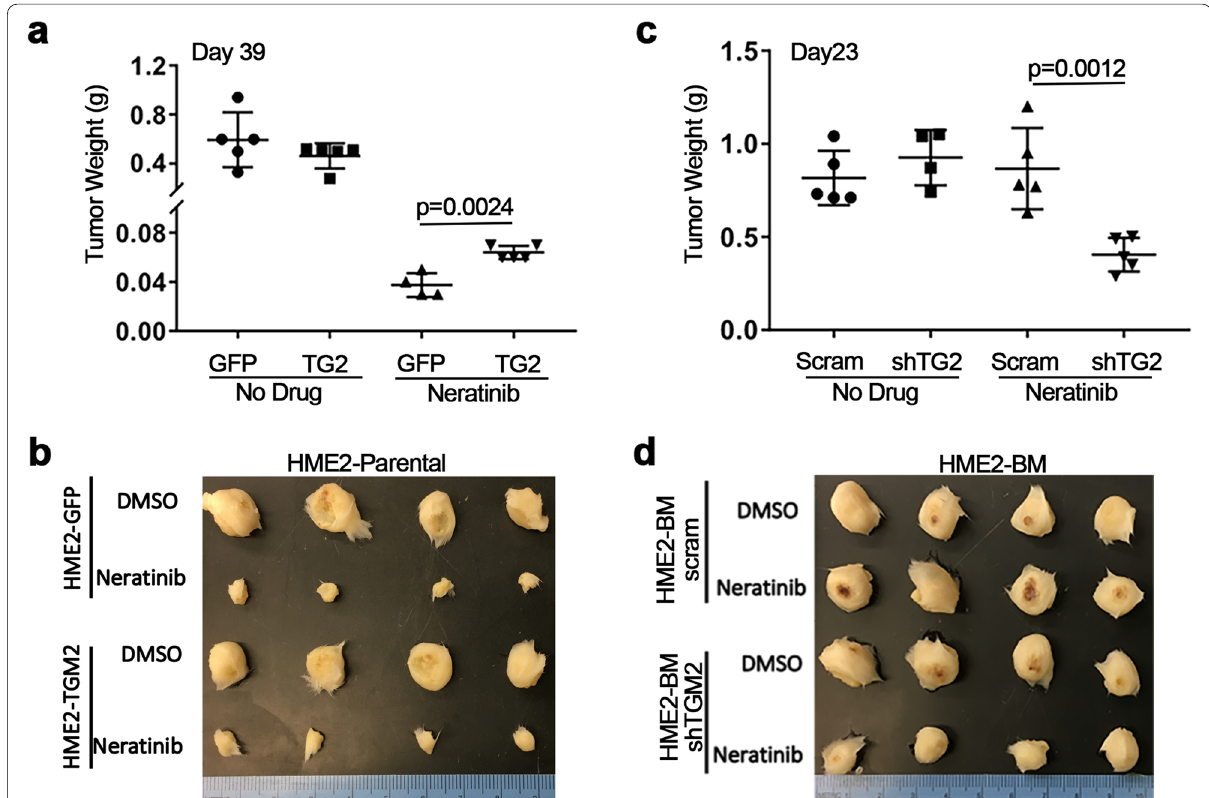
Fig. 2 Transglutaminase 2 facilitates neratinib resistance in vivo. a,c HME2 parental cells expressing GFP or TG2, and HME2-BM cells expressing a control (scram) or TG2-targeted shRNA (shTG2) were injected into the mammary fat pad. Tumor bearing mice were treated with neratinib as described in the material and methods tumors were removed and weighed upon necropsy at the indicated time points. Data are the mean of 5 mice per group SE, resulting in the indicated p -values. b,d Upon necropsy, tumors were fixed and ±